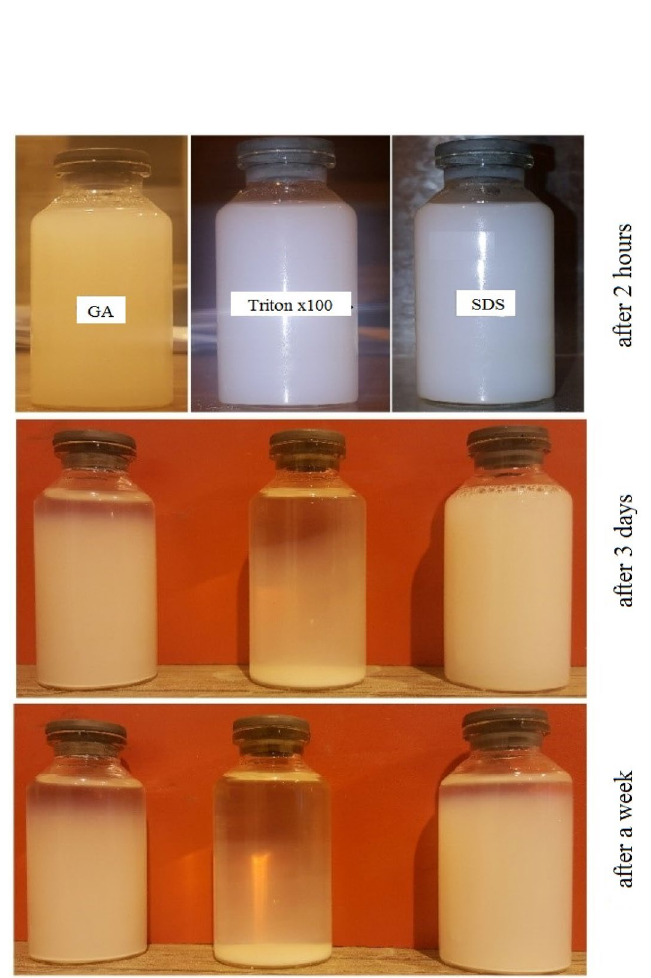
Figure 4. The Impact of different surfactants on nanofluid